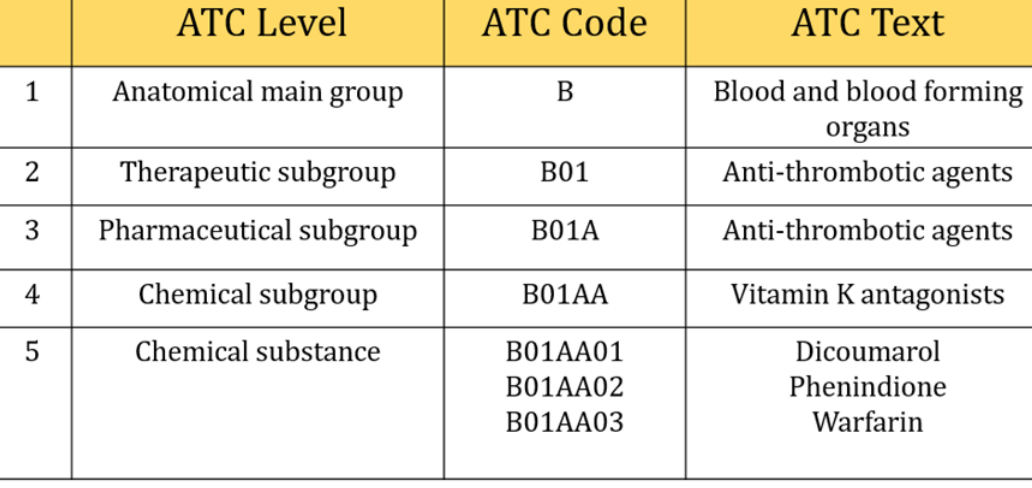
Figure 2. Selection of five digits ATC code.